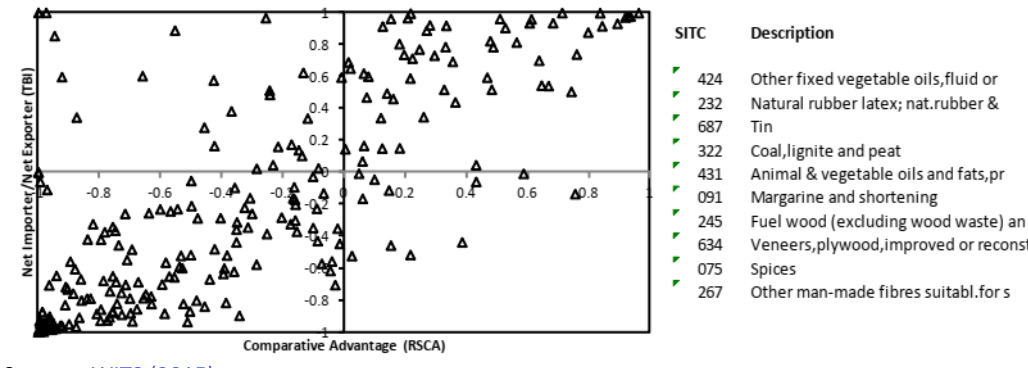
Figure 8: Products Mapping and the Top-Ten Export Products of Indonesia, 1997